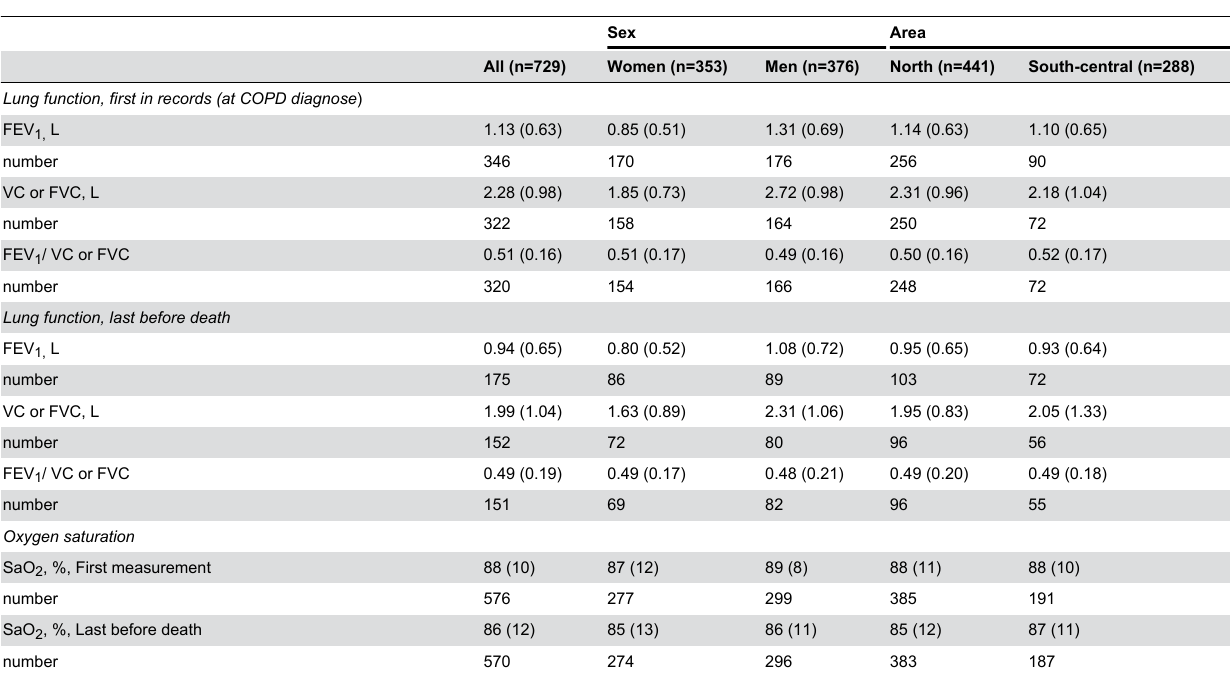
Results are given as mean values (standard deviation, SD). doi: